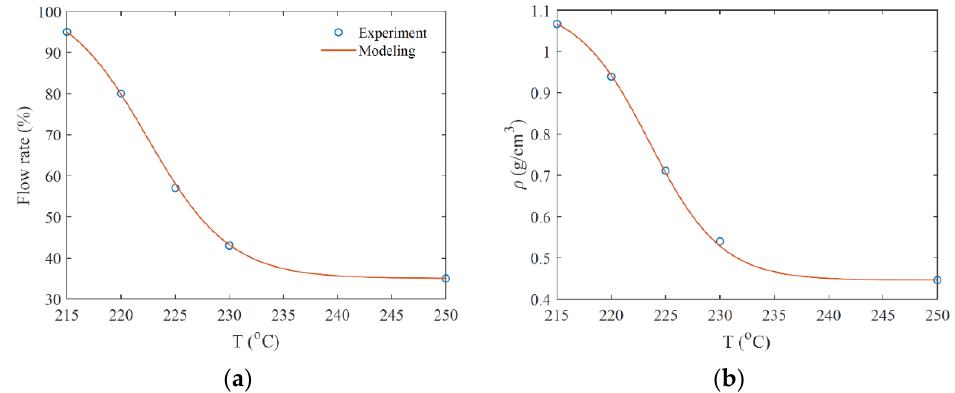
Figure 3. Corresponding adequate flow rate ( a ) and density ( b ) for different printing temperatures.